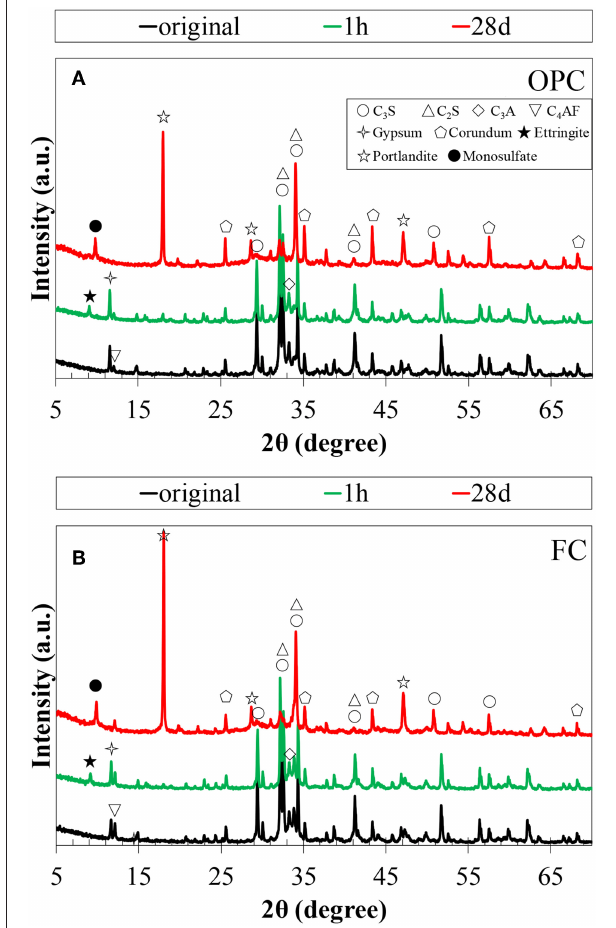
FIGURE 1 | XRD patterns of cements. (A) OPC and (B)